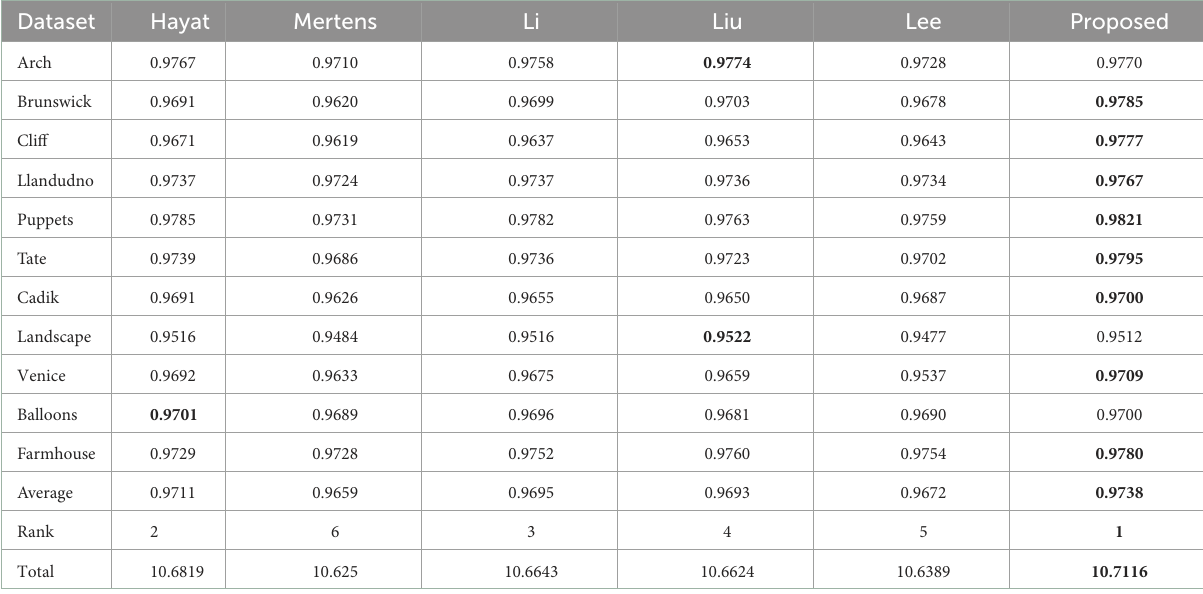
TABLE 3 Test results of LPC-SI.